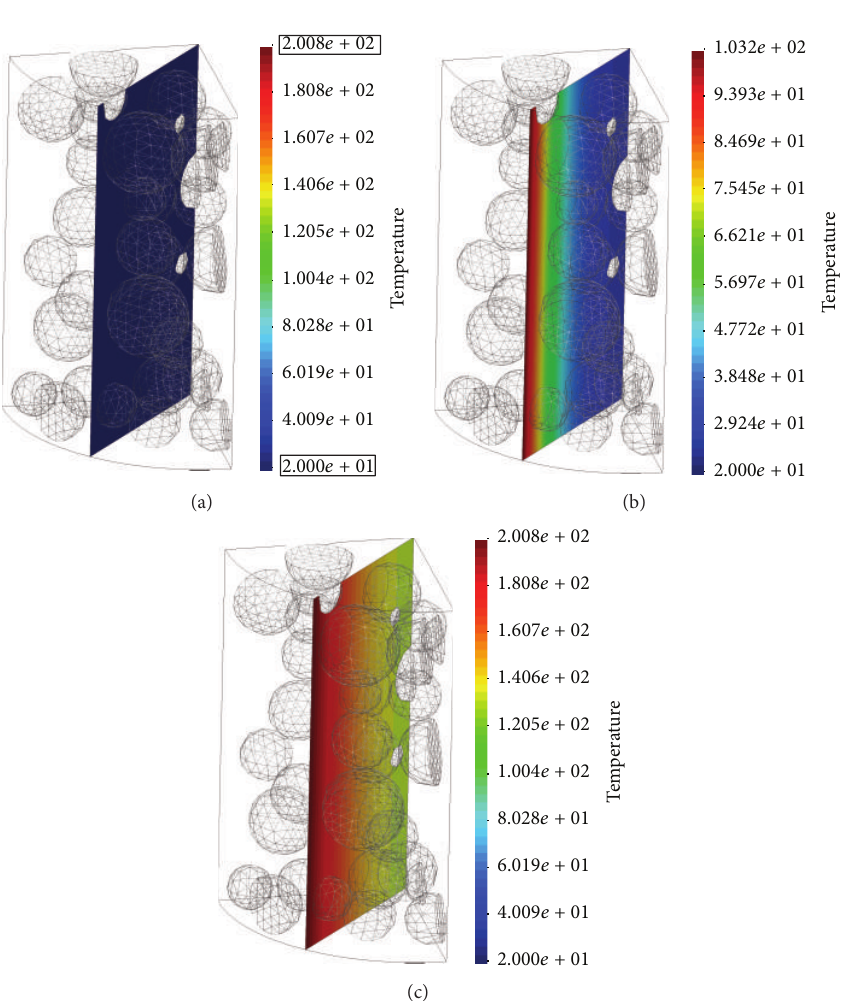
Figure 7: Temperature variation inside the sample at 0.0 min (a); 8.0 min (b); 25.0 min (c) after the start of the analysis.